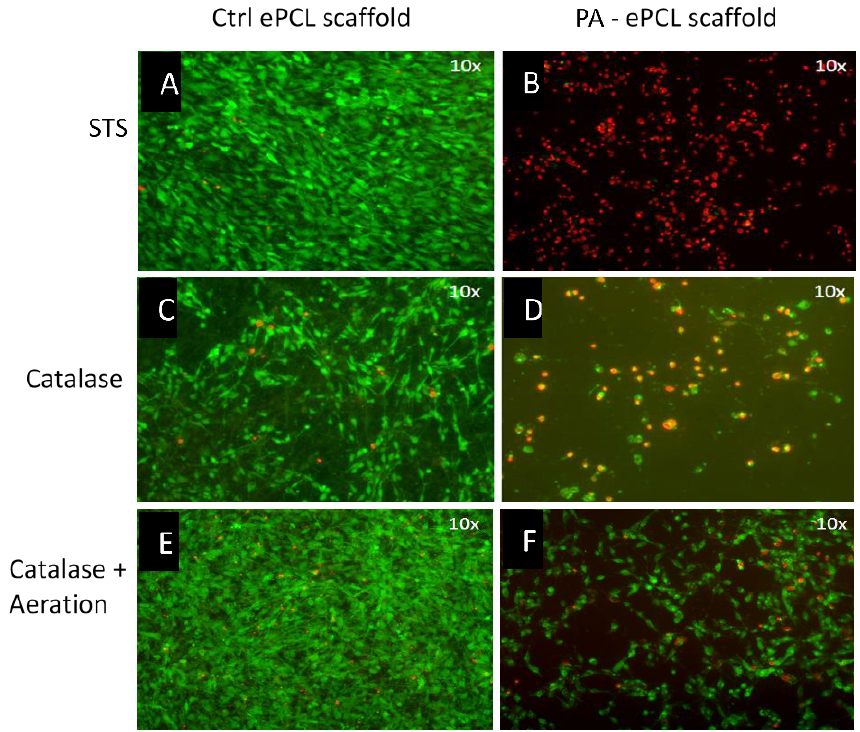
Figure 4. Effect of PA neutralization by STS (top panel); catalase (middle panel); catalase and aeration (bottom panel) on 24-hour viability of MC3T3. Panels ( A ), ( C ) and ( E ) refer to control ePCL scaffolds disinfected with 70% ethanol while ( B ), ( D ) and ( F ) are PA-treated. As can be seen, STS had no effect on cell viability; catalase was able to partially recover cell survival. Catalase combined with extensive aeration was more effective in overcoming the cytotoxic effects of PA treatment. It is important to note that control ePCL scaffolds exposed to STS, catalase and aeration protocols showed robust cell survival (left panel).